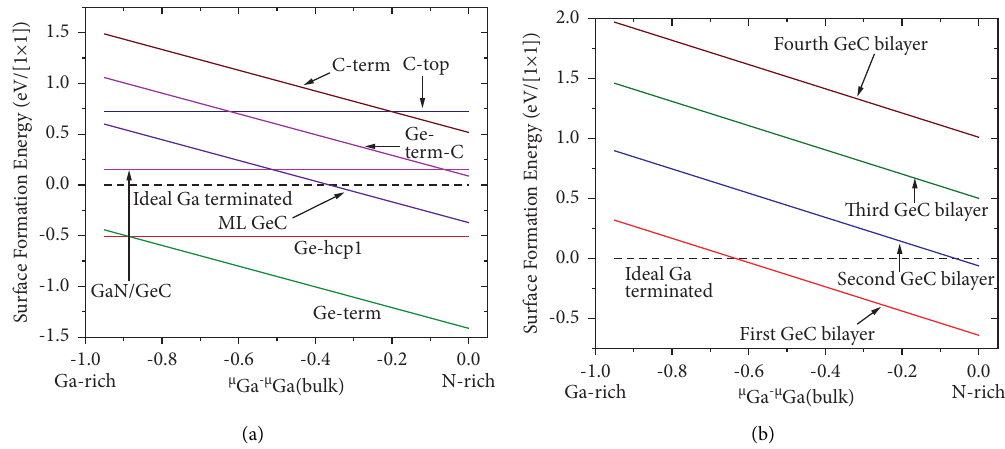
Figure 6: Surface formation energy (SFE) as a function of the Ga chemical potential for (a) different structures and (b) epitaxial